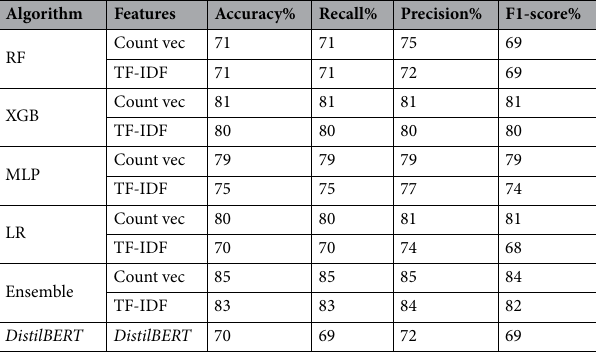
Table 6. All Feature Extraction and algorithm Results for Article3 Dataset with 10 Authors.